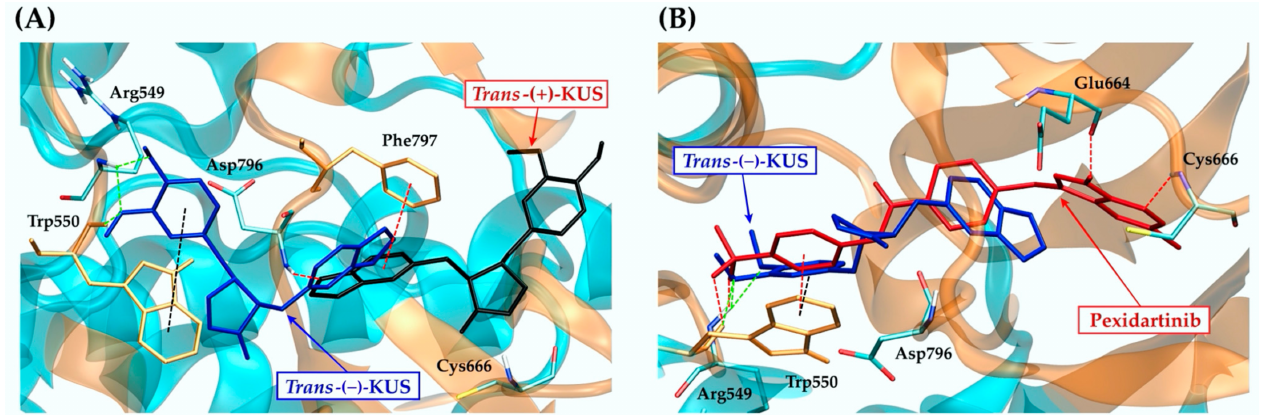
Figure 6. CSF1R binding pocket alignment: ( A ) trans -( − )-kusunokinin (blue) compared to trans -(+)- kusunokinin (black); ( B ) trans -( − )-kusunokinin (blue) compared to pexidartinib (red). Arg549 and Trp550 were responsible for hydrogen bonding between trans -( − )-kusunokinin and CSF1R (green dash line). Trp550 was responsible for π - π interaction between trans -( − )-kusunokinin and CSF1R (black dash lines). The red dash line represented hydrogen bonding or π - π stacking of the trans -(+)- kusunokinin or known inhibitor. Docking poses of the ligands and amino acids interacting with the ligands through hydrophobic interaction were shown as sticks.